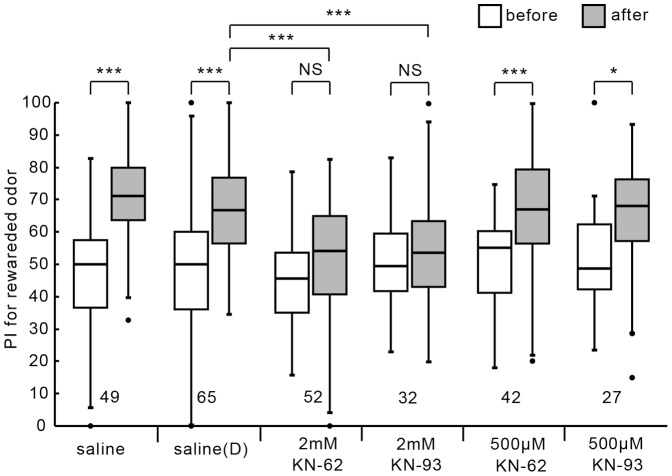
Effects of CaMKII inhibitors on 1-day retention.Two control groups were each injected with 3 µl of saline or saline containing 1% DMSO (designated as saline (D)) 20 min prior to 3-trial conditioning. Another four groups were each injected with 3 µl of saline containing 2 mM KN-62, 2 mM KN-93, 500 µM KN-62 or 500 µM KN-93 (dissolved in 1% DMSO) 20 min prior to 3-trial conditioning. Relative preference between the rewarded odor and control odor was tested before and at 1 day after training. Preferences indexes (PIs) for the rewarded odor before (white bars) and after (grey bars) training are shown as box and whisker diagrams. The line in the box is the median and the box represents the 25–75 percentiles. Whiskers extend to extreme values as long as they are within a range of 1.5× box length from the upper or lower quartiles. Any data not included between the whiskers are plotted as outliers with dots. Odor preferences before and after training are compared by WCX test. Odor preferences after training of different groups were compared by the M-W test. The results of statistical comparisons are shown by asterisks (*** P<0.001, ** P<0.01, * P<0.05, NS P>0.05, adjusted by Holm's method). The number of animals tested is shown at each data point in this figure and in subsequent figures.